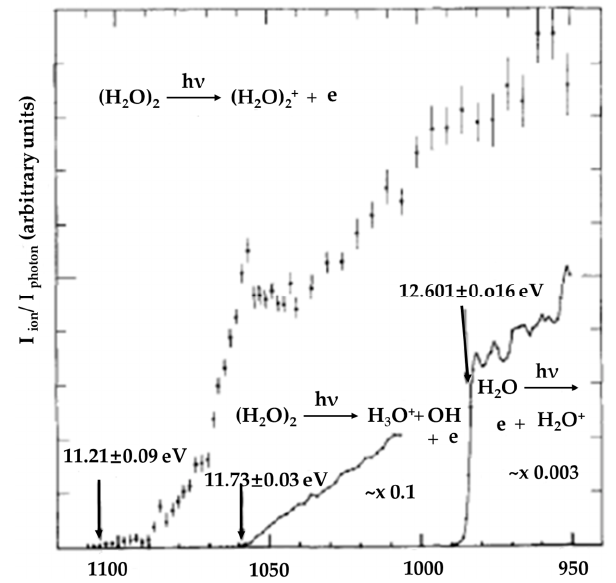
Figure 6. Photoion yield curves of (H 2 O) 2 + • , H 3 O + and H 2 O + • in the spectral range 95–1120 Å. Figure adapted from [40] with permission. Copyright 1977 American Institute of Physics.